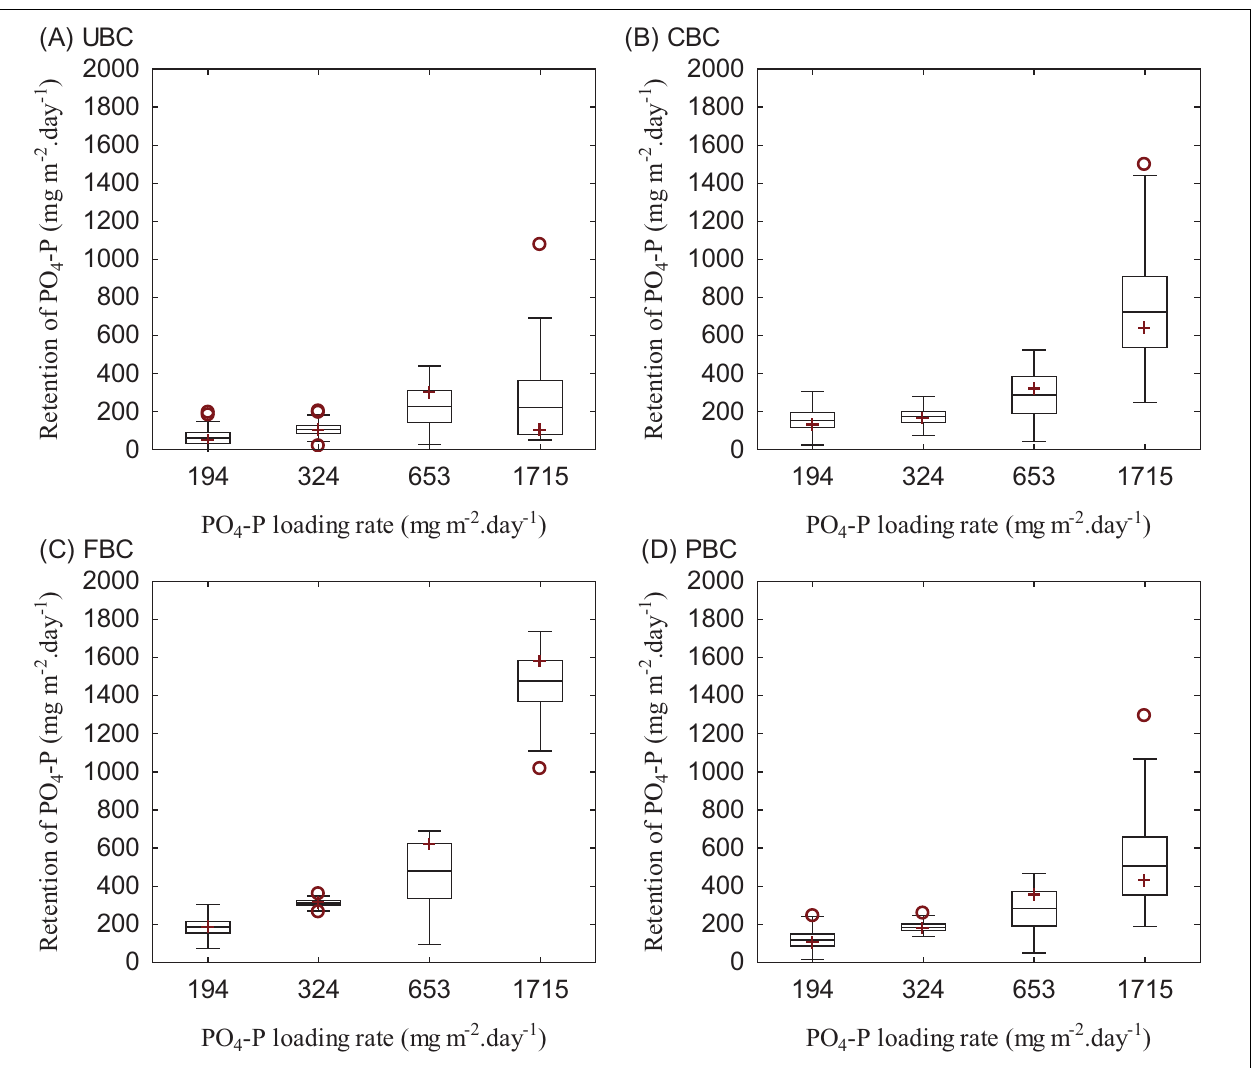
FIGURE 6 | Boxplots of retention of phosphate-phosphorus (PO 4 -P, mg m − 2 day − 1 ) in (A) unimpregnated biochar filter (UBC), (B) CaO-impregnated biochar filter (CBC), (C) FeCl 3 -impregnated biochar filter (FBC), and (D) biochar filter mixed with Polonite R (cid:13) (PBC), in response to increasing phosphate loading rate (PLR). The middle line (–) of the box is the mean, the cross (+) is the median, the box is the confidence interval, the whiskers are the non-outlier range, and the red dots are outliers and extreme